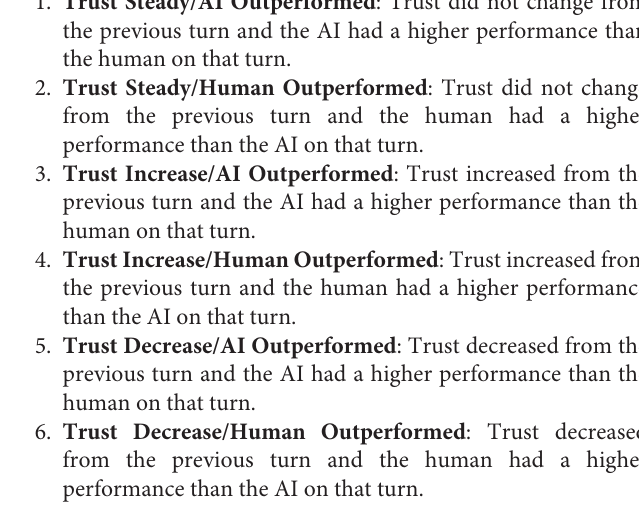
FIGURE 13 | Changes to trust per